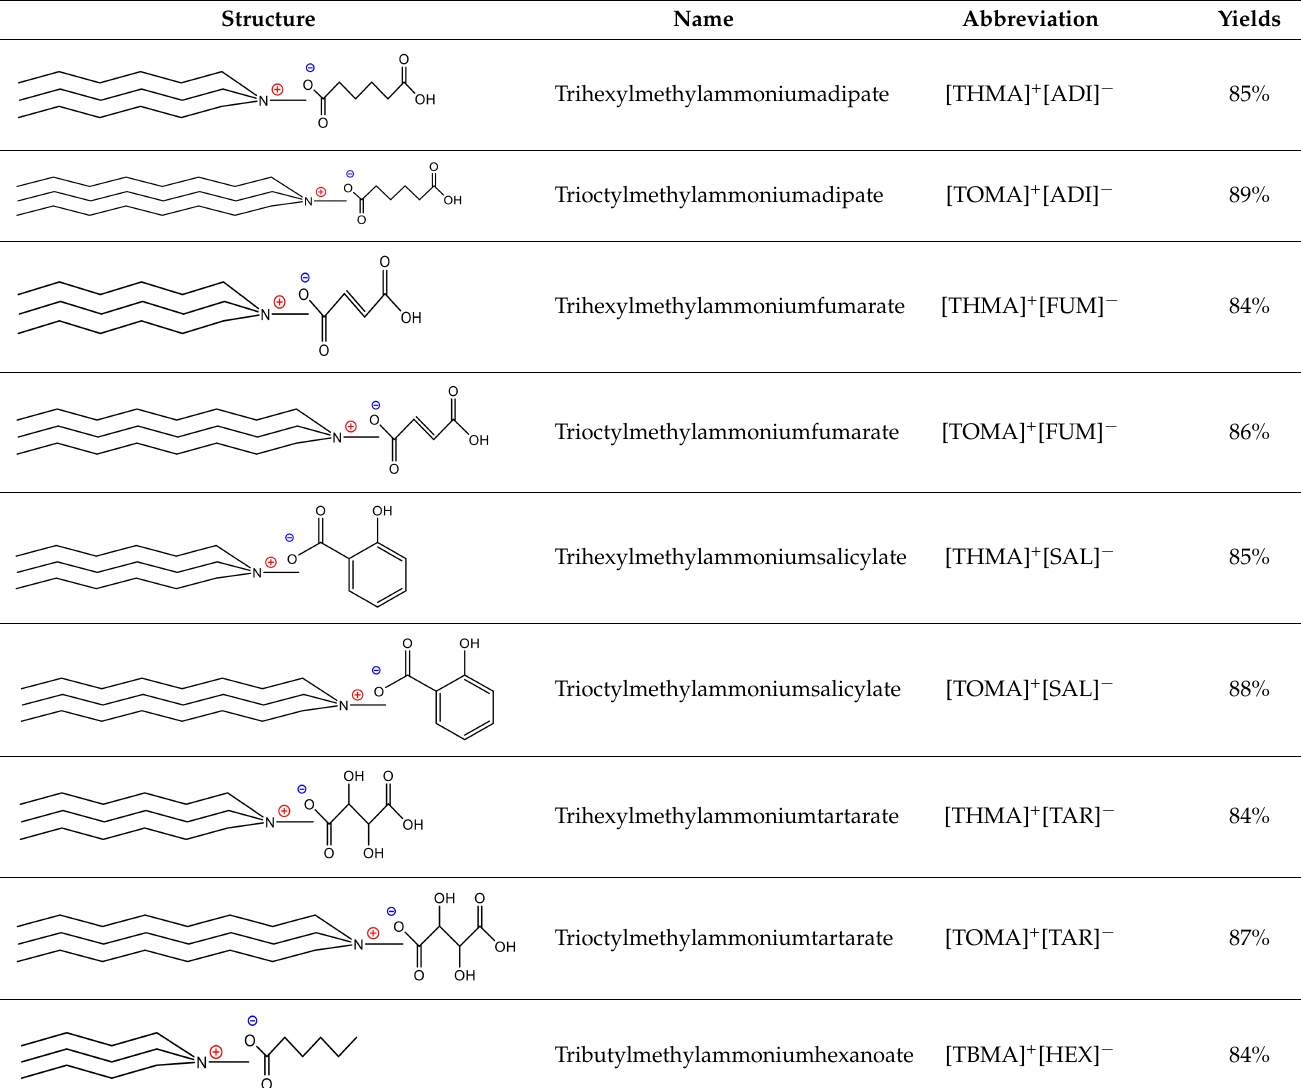
Table 1. Structure of the synthesized